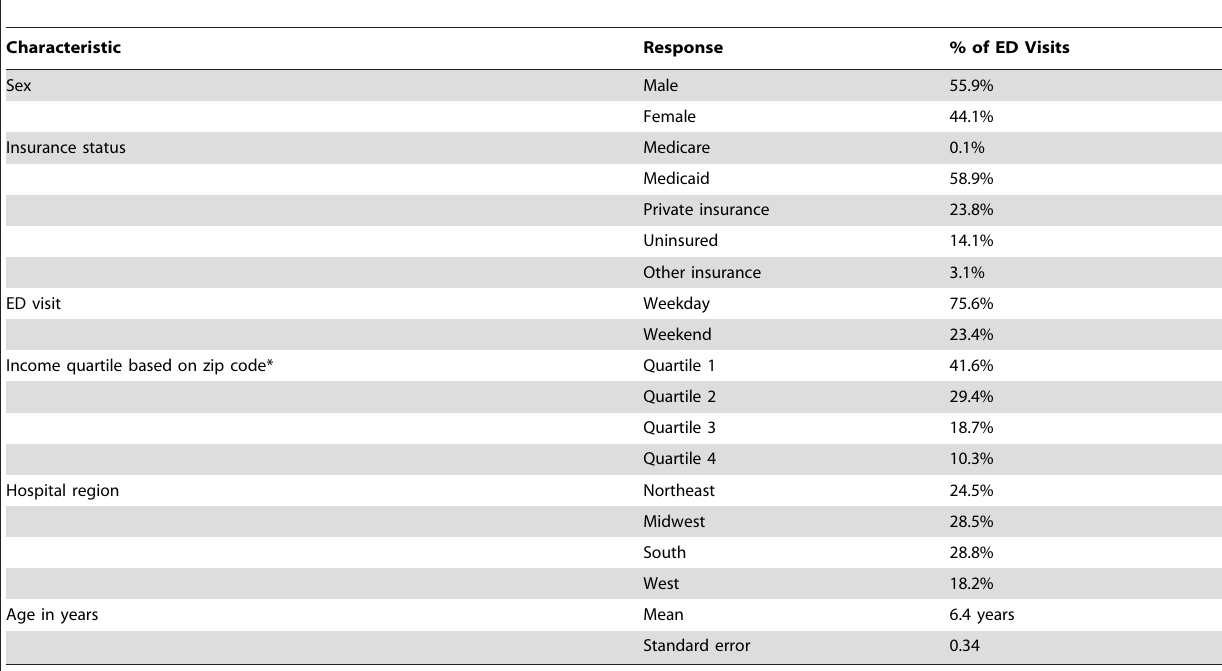
Table 1. Characteristics of ED Visits due to Child Physical Abuse (Total N=16,897).